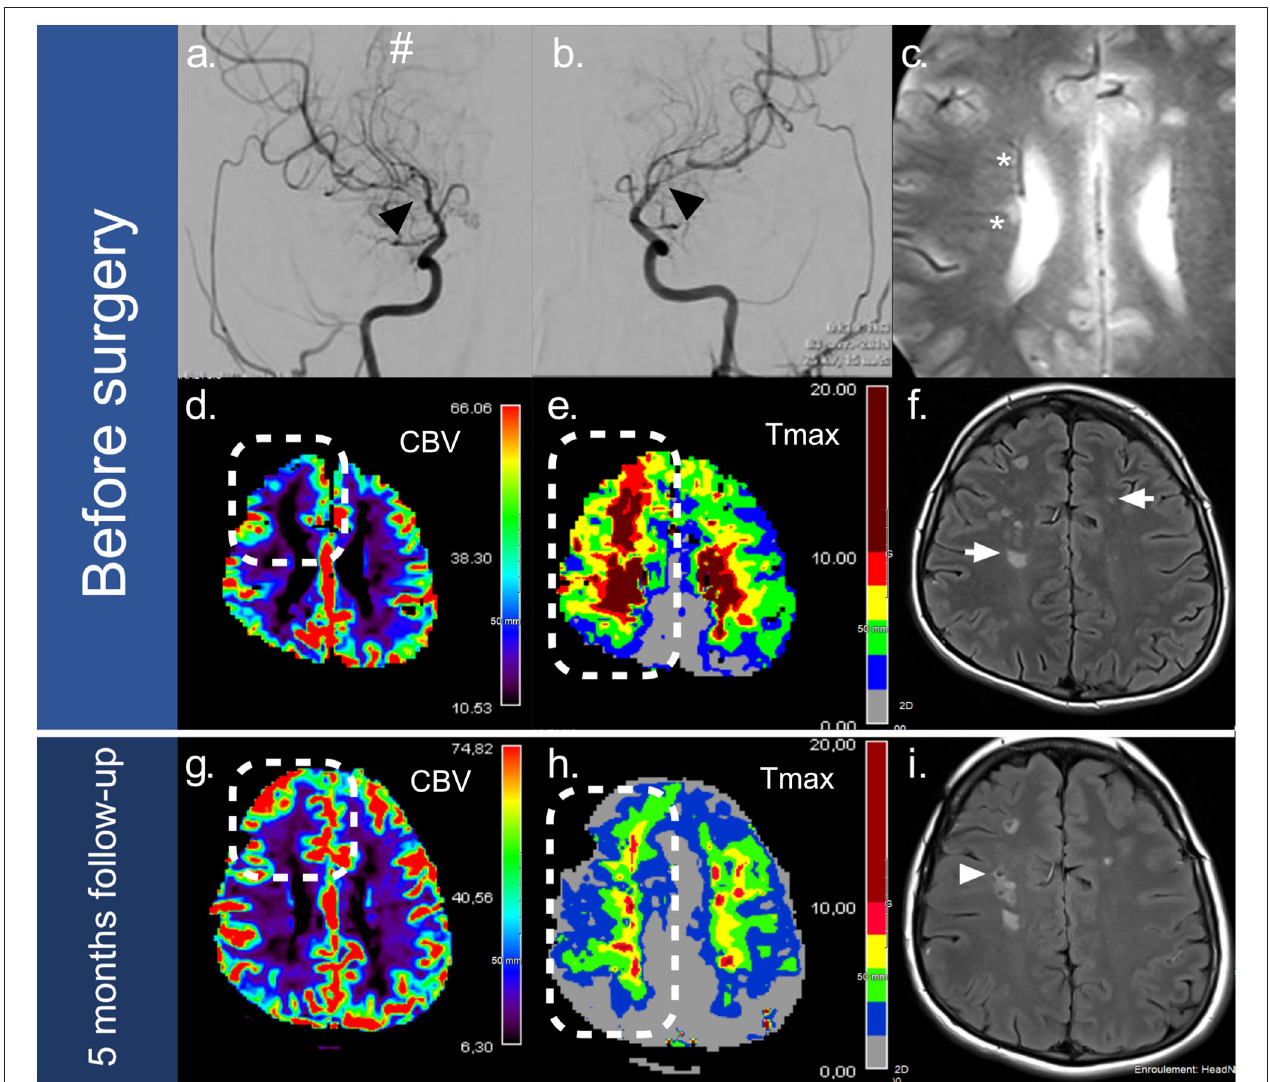
FIGURE 1 | Imaging of moyamoya lesions and 5-month follow-up. Before surgery, moyamoya lesions were observed on the right (a) and left (b) internal carotid artery angiograms, revealing bilateral stenosis of the internal carotid arteries termination (black arrows), with moyamoya collaterals (#). Magnetic resonance imaging (c–f) found asymmetric enlargement of the medullary veins in relation with cerebral hypoperfusion (*) visible on the T2-GE sequence (c) , associated with bilateral watershed ischemic lesions on FLAIR (f) (white arrow). Perfusion imaging pointed out severe hypoperfusion in the right frontal junctional territory (squared dots) on the cerebral blood flow cartography (CBV) (d) and the TMAX cartography (e) . A five-month follow-up scan (g–i) showed significant improvement of the left frontal lobe perfusion after surgery with: (1) an increase in cerebral blood flow ( d vs. g ) (squared dots), and (2) shrinkage of delayed perfusion areas on TMAX > 6s ( e vs. h ) (rectangular dots). No recurrent ischemic lesions were observed after surgery. Preoperative ischemic lesions progressed into lacunar lesions ( f vs. i ) (white arrowhead).